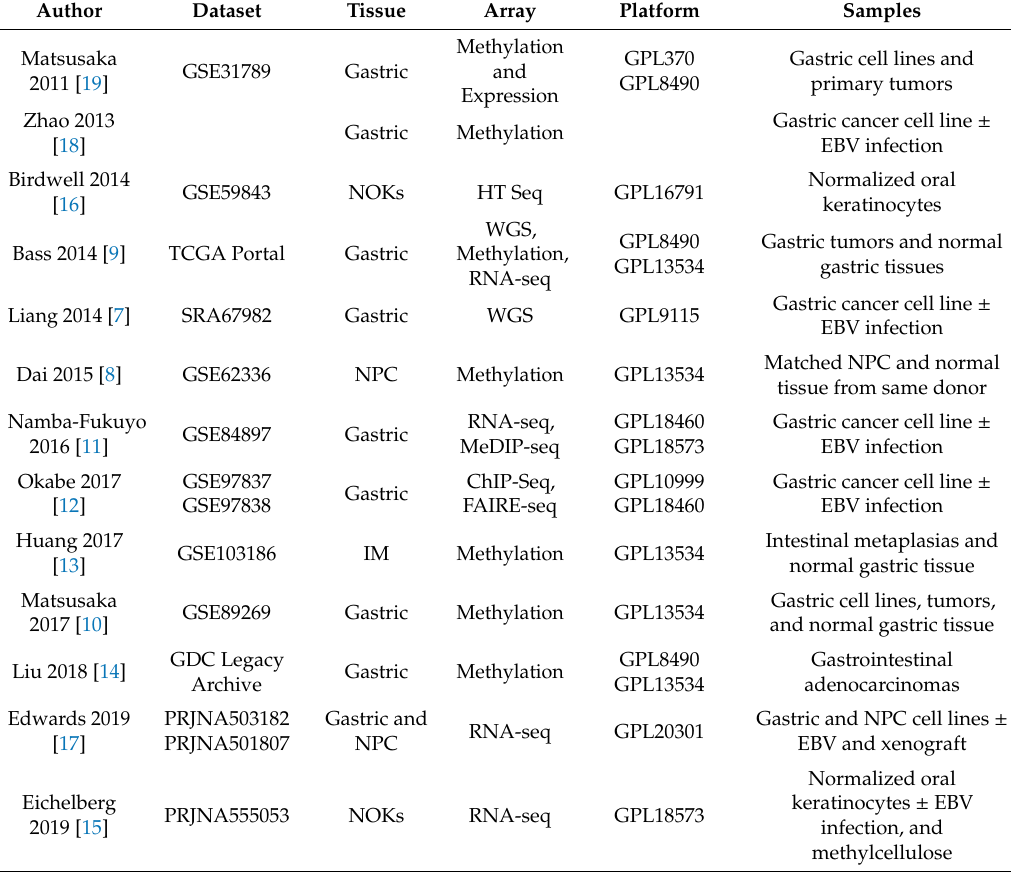
Table 1. Details of the largescale datasets used in this review with data accession numbers where available. Gene lists for analysis were downloaded where available as supplemental files in original papers. First author and year listed with reference